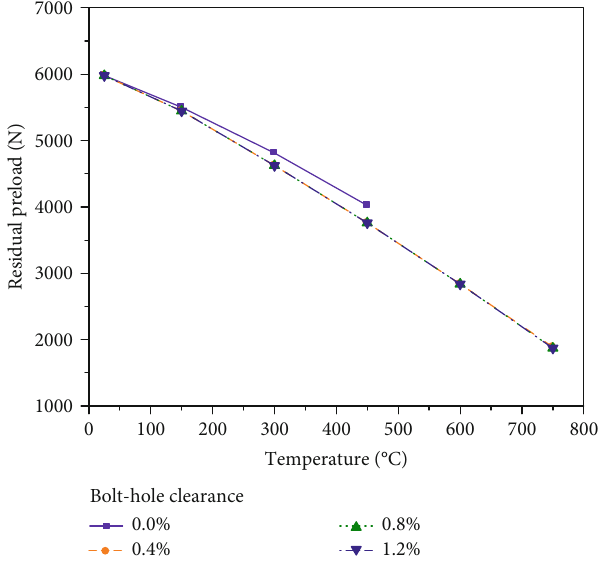
Figure 6: Variation of residual preload with temperature for the studied CMC and superalloy bolted